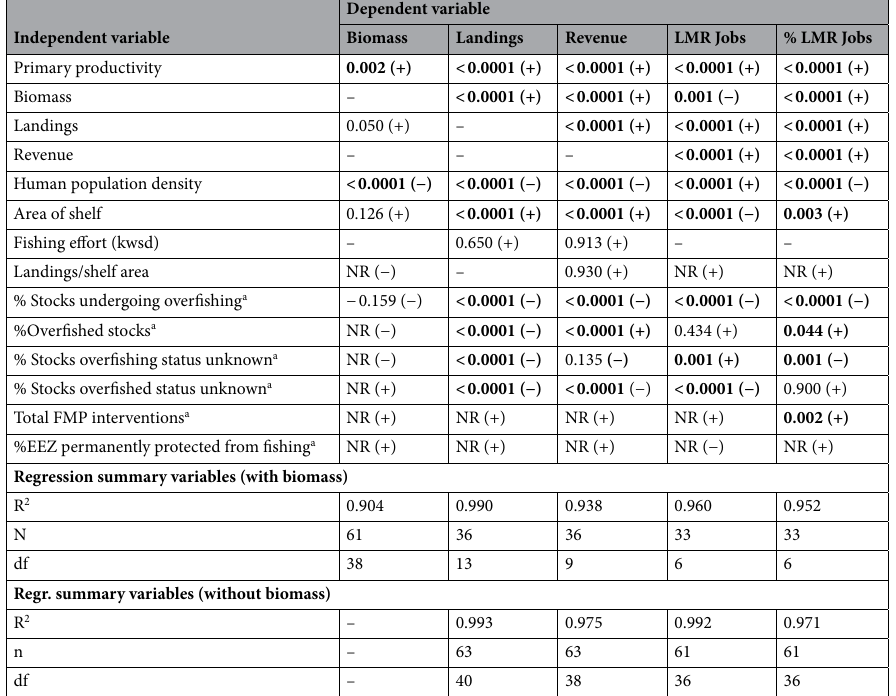
Table 1. Multiple regression relationships among independent and dependent variables within all US regions. p-values and sign of Pearson correlation coefficient value (i.e., + or − in parenthesis) are shown for relationships among independent variables and each dependent variable within ocean economies. Summary variables for each multiple regression relationship (R 2 , n, df) among a given dependent variable and all independent variables are included. Values are shown for regressions that include biomass (and without) to account for biomass estimates not being available for each US region of interest examined. Bold values indicate statistically significant relationships (p < 0.05). EEZ exclusive economic zone, FMP Fishery Management Plan, kwsd kilowatt sea days, NR not reported. a Indicates that only values from 2017 were used. Primary productivity reported as g Carbon m −2 year −1 .